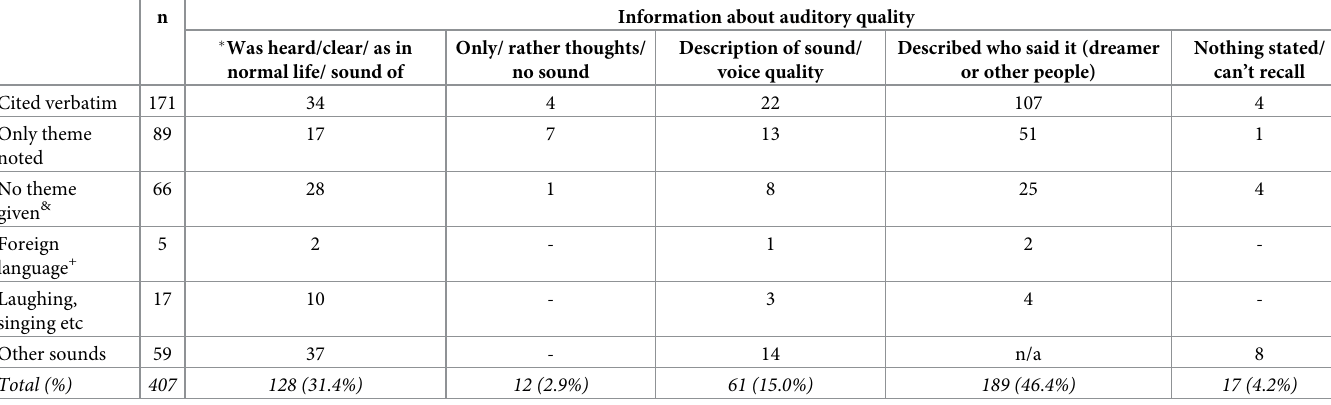
Table 1. Auditory qualities of speech and other